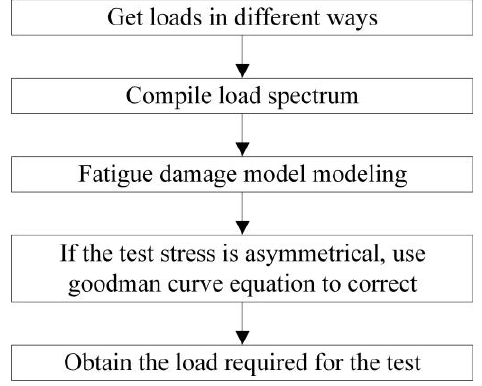
Figure 2. Methods of accelerating fatigue test.